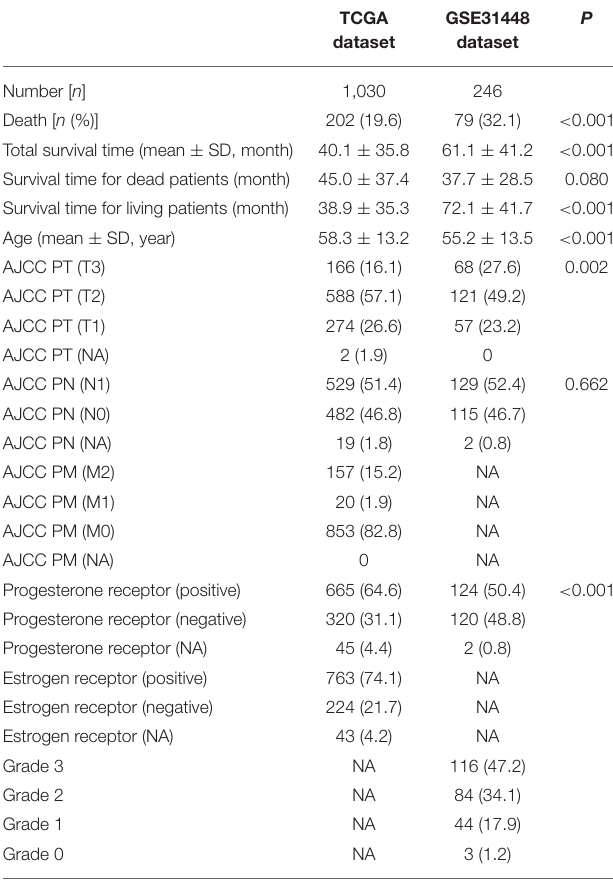
TABLE 1 | Clinical features of included